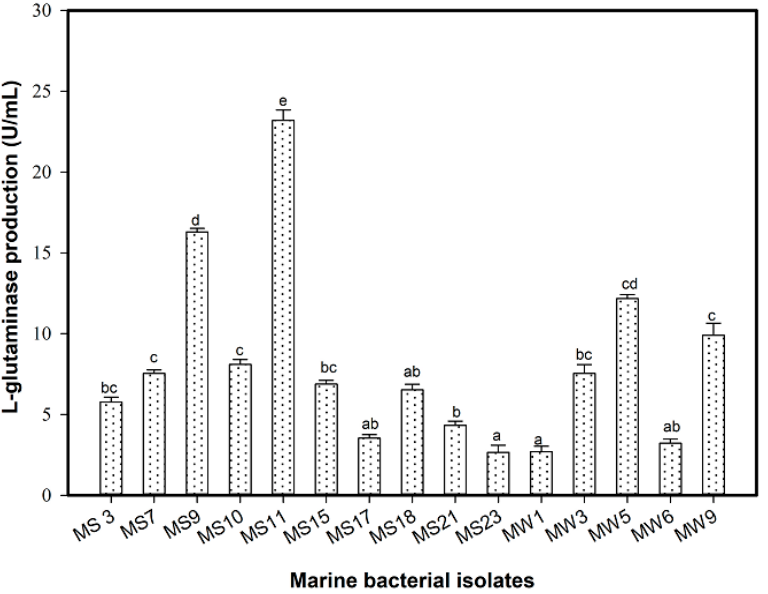
Figure 1. Quantitative screening of marine L-glutaminase producing bacteria. Mean ± standard error ( n = 3) is presented. Vertical bars indicate the standard errors of the means. Means followed by different letters are significantly different at p < 0.05.